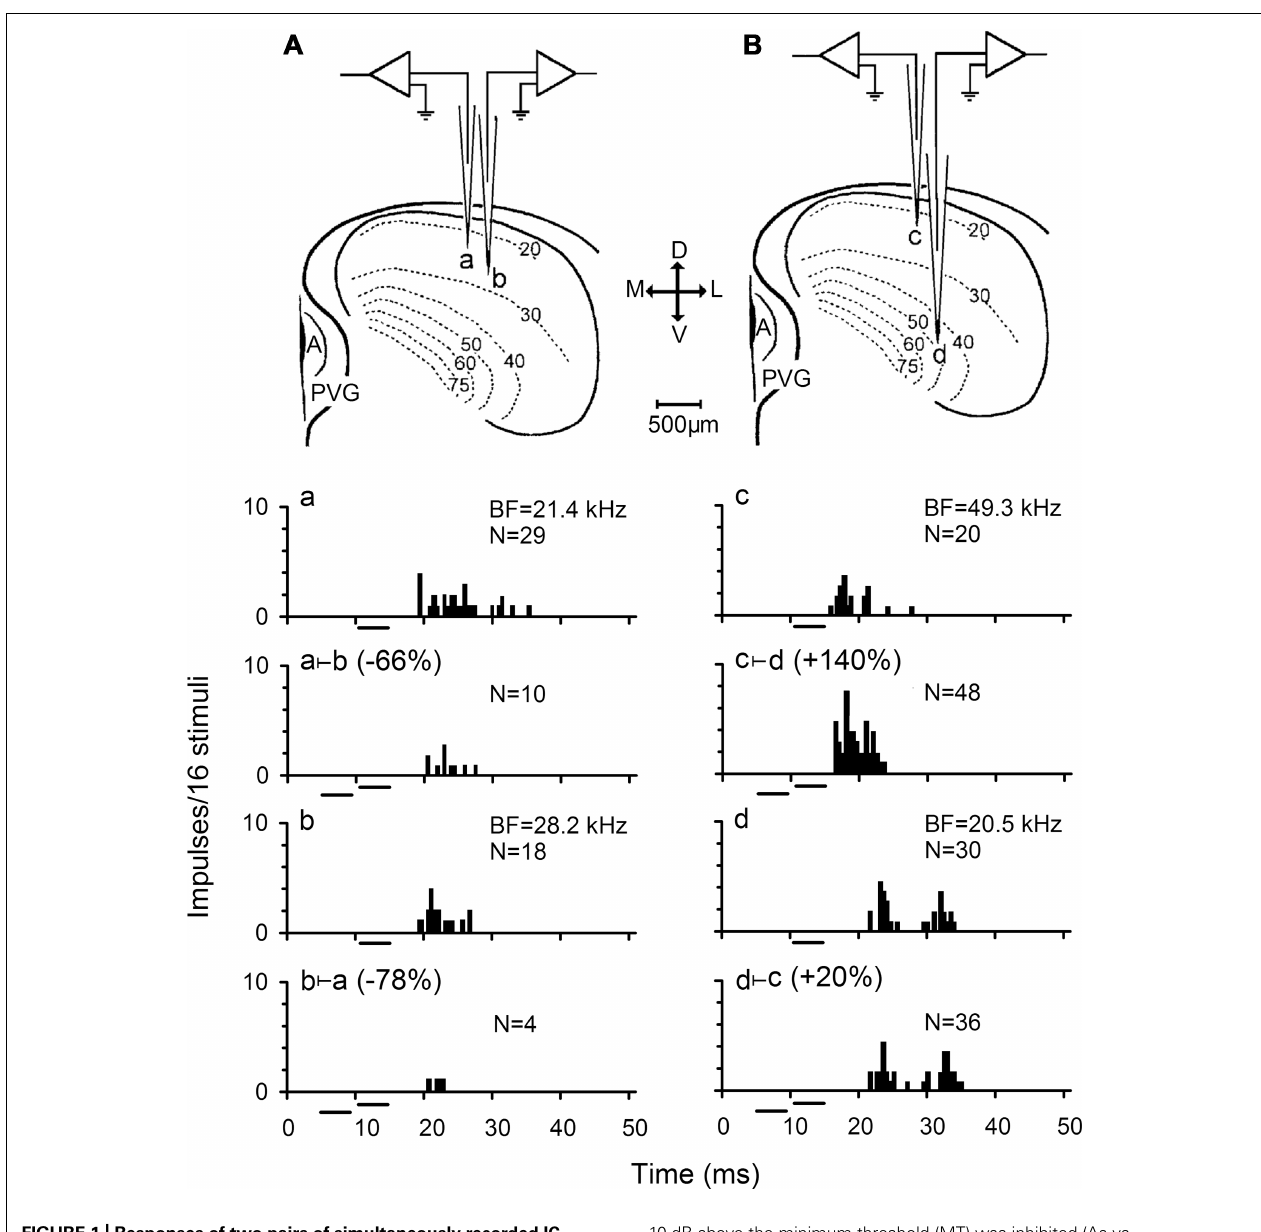
FIGURE 1 | Responses of two pairs of simultaneously recorded IC neurons. (A,B) Sketches showing the experimental arrangement for simultaneous recording two pairs of IC neurons. a and b represent a pair of IC neurons in iso-frequency laminae while c and d are another pair of IC neurons in non-iso-frequency laminae. M, medial; L, lateral; D, dorsal;V, ventral; A, aqueduct; PVG, paraventricular gray.The firing rates of these neurons in response to a 4 ms best frequency (BF) sound at